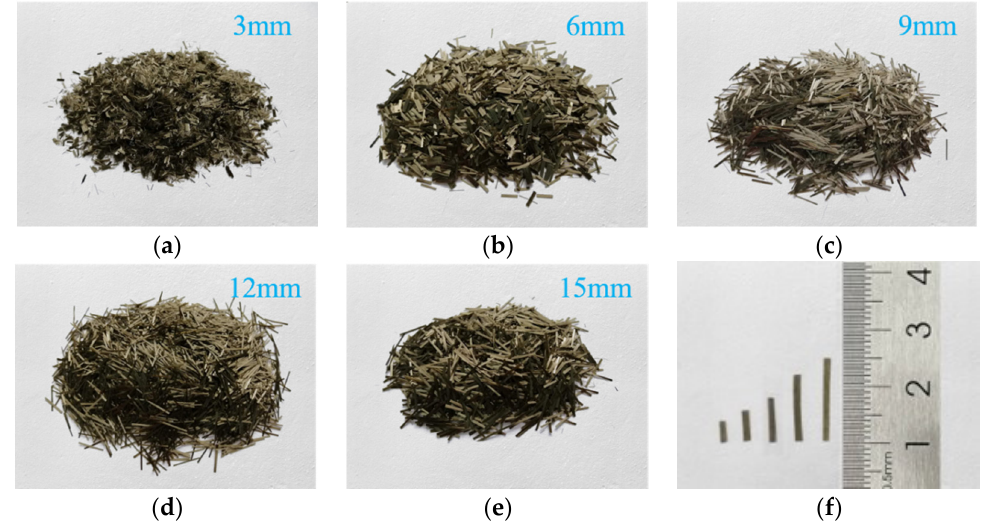
Figure 2. Basalt fiber, with length: ( a ) 3 mm; ( b ) 6 mm; ( c ) 9 mm; ( d ) 12 mm; ( e ) 15 mm; and ( f ) a comparison of fiber lengths. Table 2. Properties of the basalt fiber.